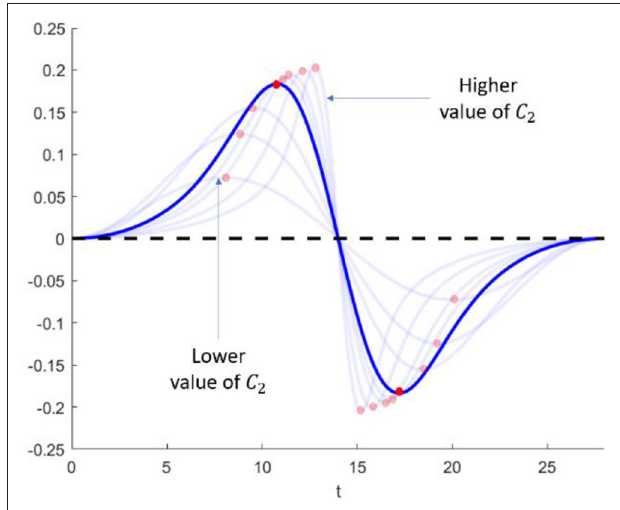
Frontiers in Applied Mathematics and Statistics |